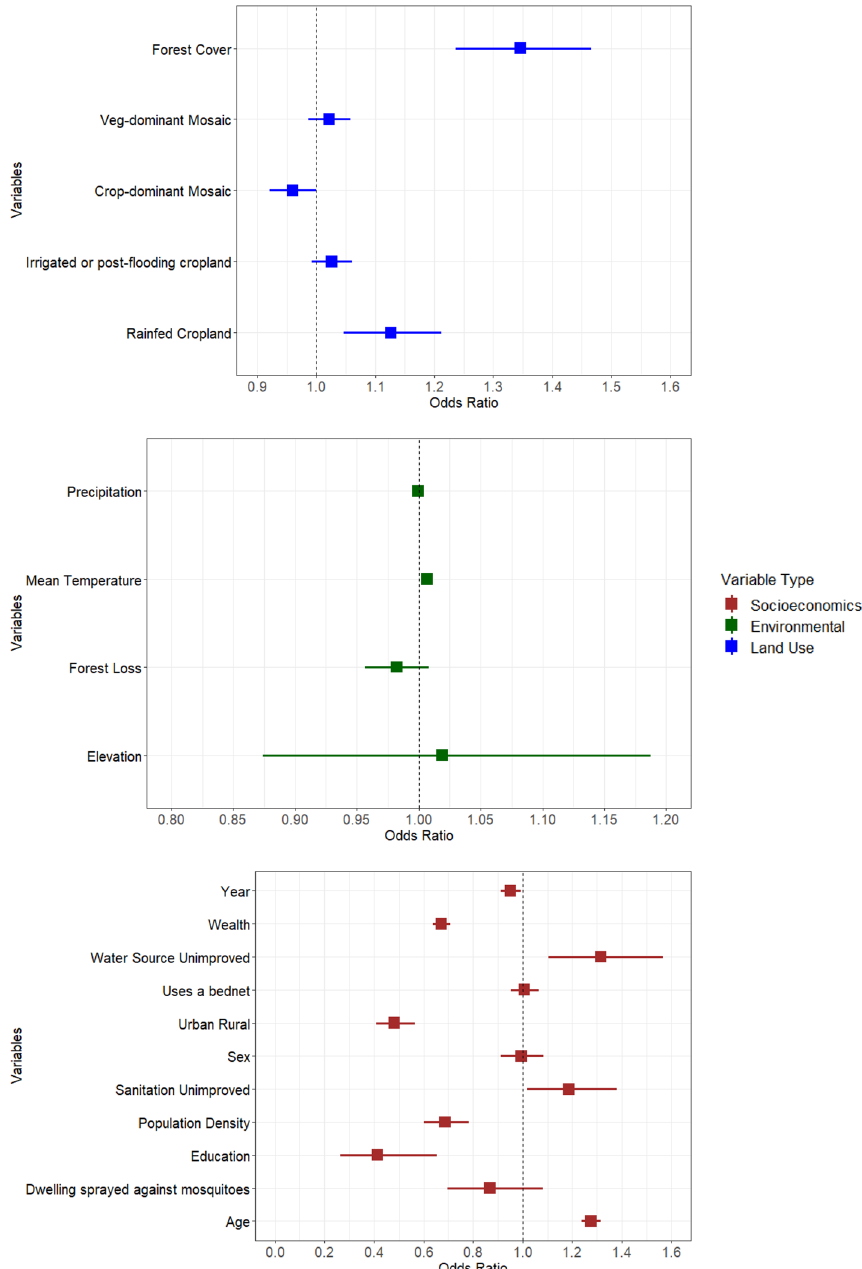
Figure 2. Sub-Saharan regional multivariate analysis—a multivariate analysis that assesses the factors associated with the odds of childhood malaria. Error bars are defined as the 95% confidence interval. Variables increasing childhood malaria have odds ratios greater than 1 to the right of the vertical line. Crop-dominated mosaic denotes mosaic cropland and veg-dominated mosaic denotes mosaic natural vegetation within the European Space Agency (ESA) Climate Change Initiative Land Cover (CCI-LC)